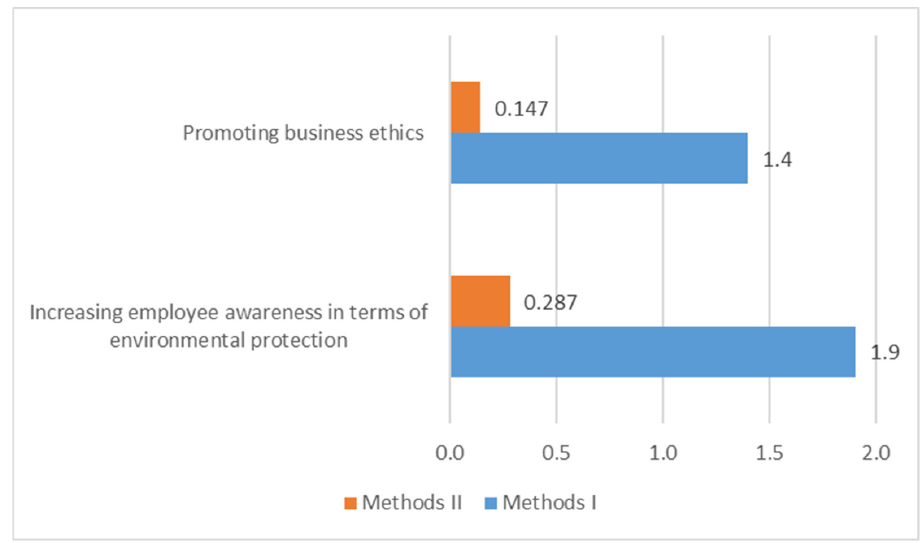
Figure 11. Summary of the results for environmental factors with both methods. Authors’ own study.